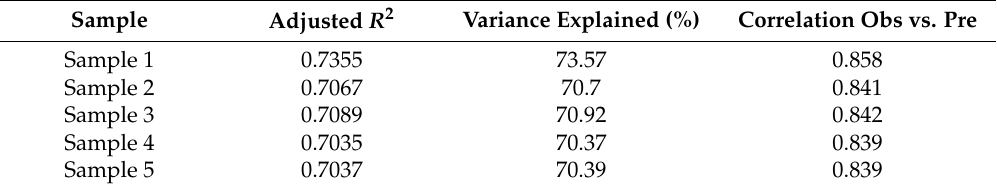
Table 6. Adjusted R 2 and correlation values between observed (obs) and prediction (pre) values of five intermediate models using Multiple Linear Regression.